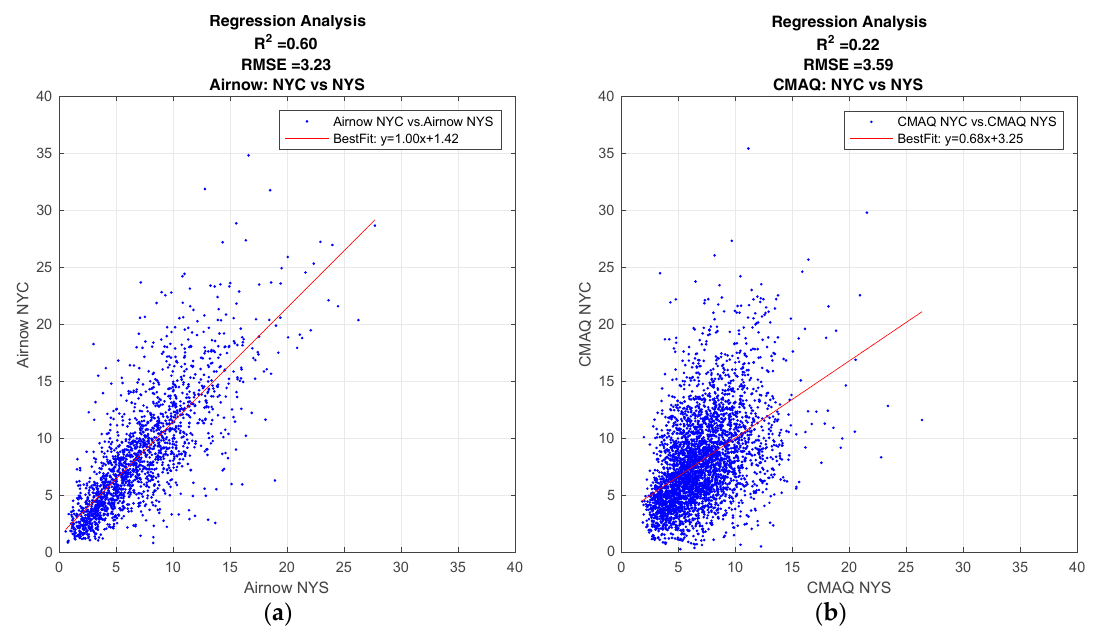
Figure 3. Regression analysis comparing PM 2.5 levels between NYC and the rest of NYS (non-NYC sites). ( a ) Multi-year day-averaged PM 2.5 analysis from NYSDEC ground observations; ( b ) CMAQ model comparison between NYC and NYS.